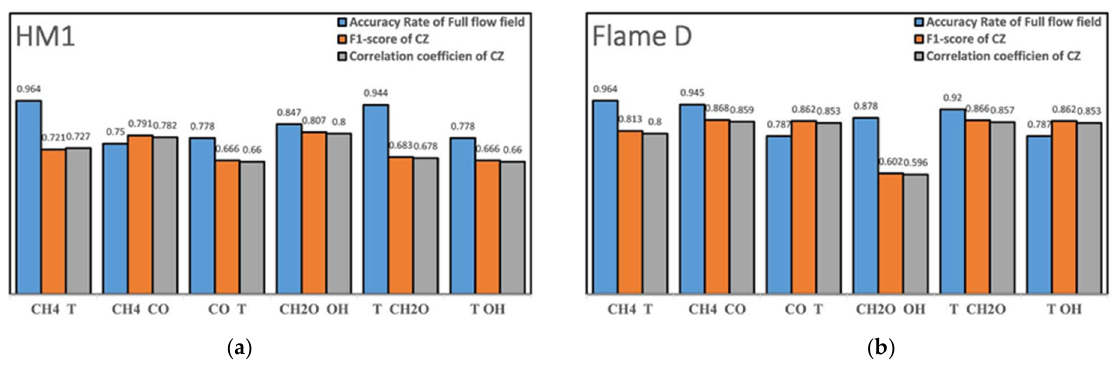
Figure 14. Identification accuracies with two-dimensional BPNN: ( a ) HM1; ( b ) Sandia Flame D .